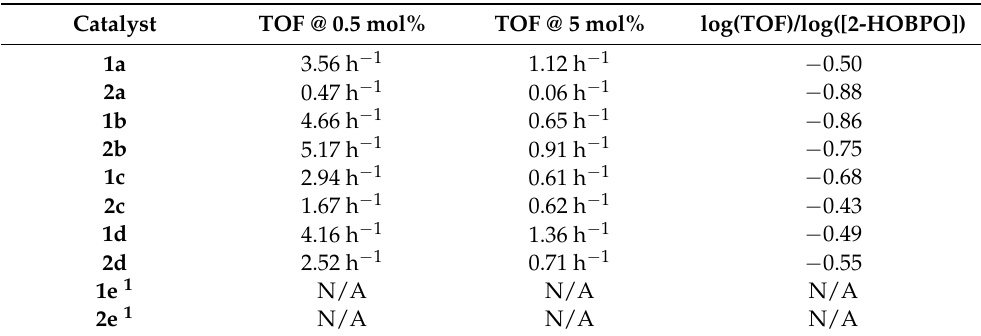
Figure 8. ( a ) Linear fits of log(TOF) as a function of log([2-HOBPO]) at 180 ◦ C in xylenes; ( b ) a comparison of initial-rate TOF of each 2-HOBPO at 0.5 mol% loading and at 5.0 mol% loading. By plotting each catalyst with coordinates based on their modeled TOF at a low loading of 0.5 mol% and at a high loading of 5.0 mol% (Figure 8b), it can be seen that the catalyst with the highest observed TOF in this study ( 2b ) is not the same as the catalyst with the highest observed rate ( 1d ). Selected data shown graphically in Figure 7 is shown in tabular format in Table 4. Table 4. Comparison of initial-rate turnover frequencies for the 2-HOBPOs examined in xylenes at 180 ◦ C, both as a function of catalyst loading and at high